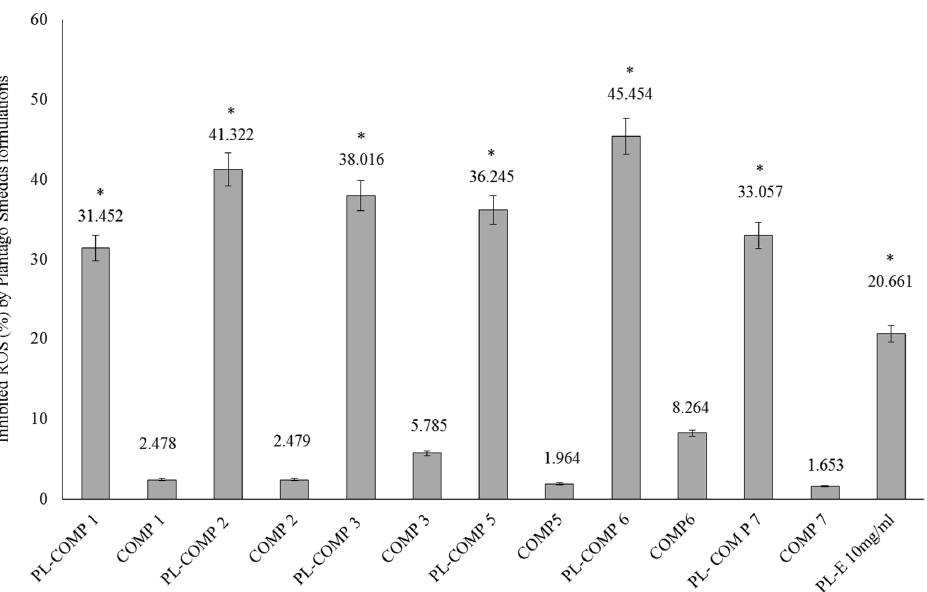
Figure 5. Inhibition of (ROS, %) by different PL-compositions. The positive control was P. lanceolata extract in a concentration 10 mg/mL. The negative controls were the compositions without P. lanceolata extract. Values are expressed as means ± SD, n = 5. Significant differences between PL-composition groups and the positive control group have been marked with an asterisk.